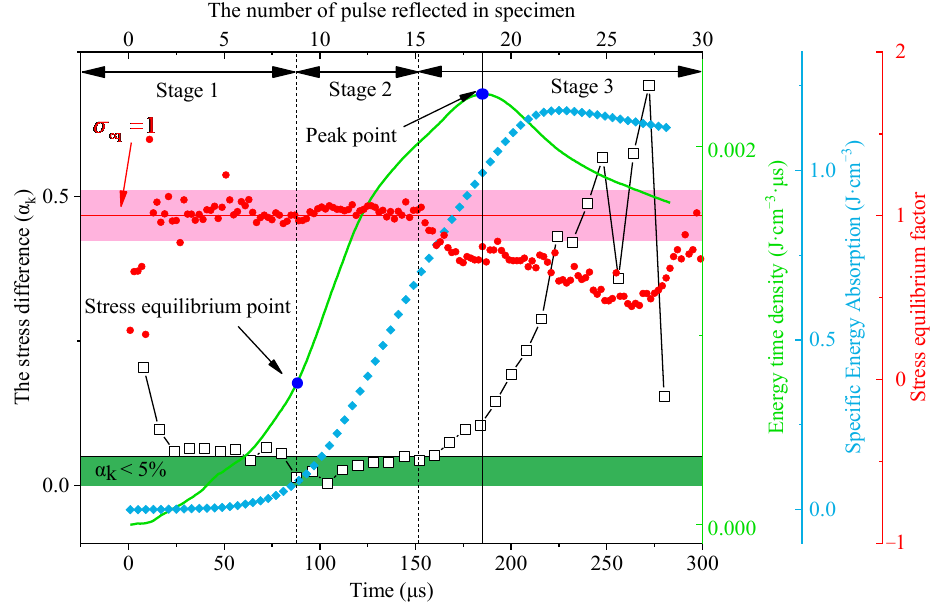
Figure 4. A typical dynamic test for stress equilibrium. The stress difference curve in Figure 4 can be divided into three stages: stress superpo- sition stage, stress equilibrium stage, and stress deterioration. In the stress superposition stage, the stress wave propagates repeatedly and is superimposed on the granite